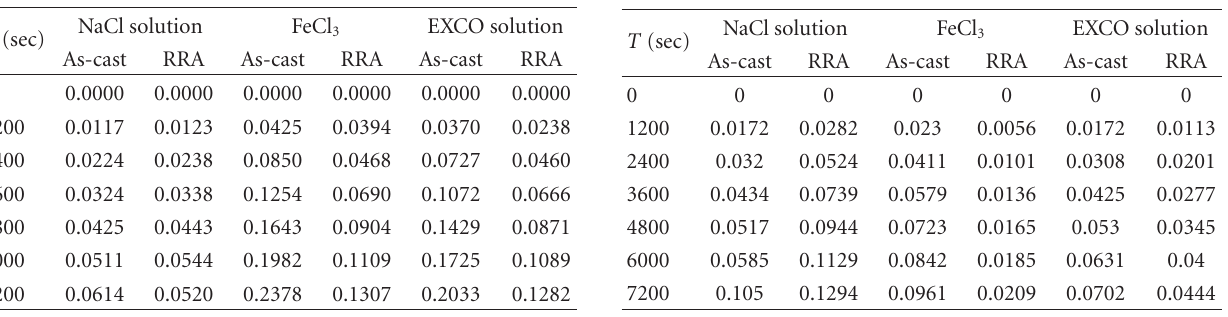
Table 13: Electrochemical corrosion rate for the 1.81% Mg